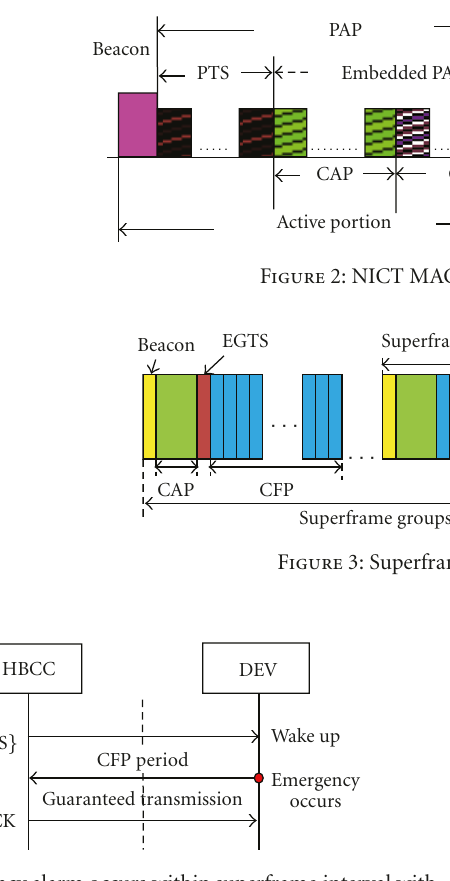
Figure 4: Emergency alarm occurs within superframe interval with